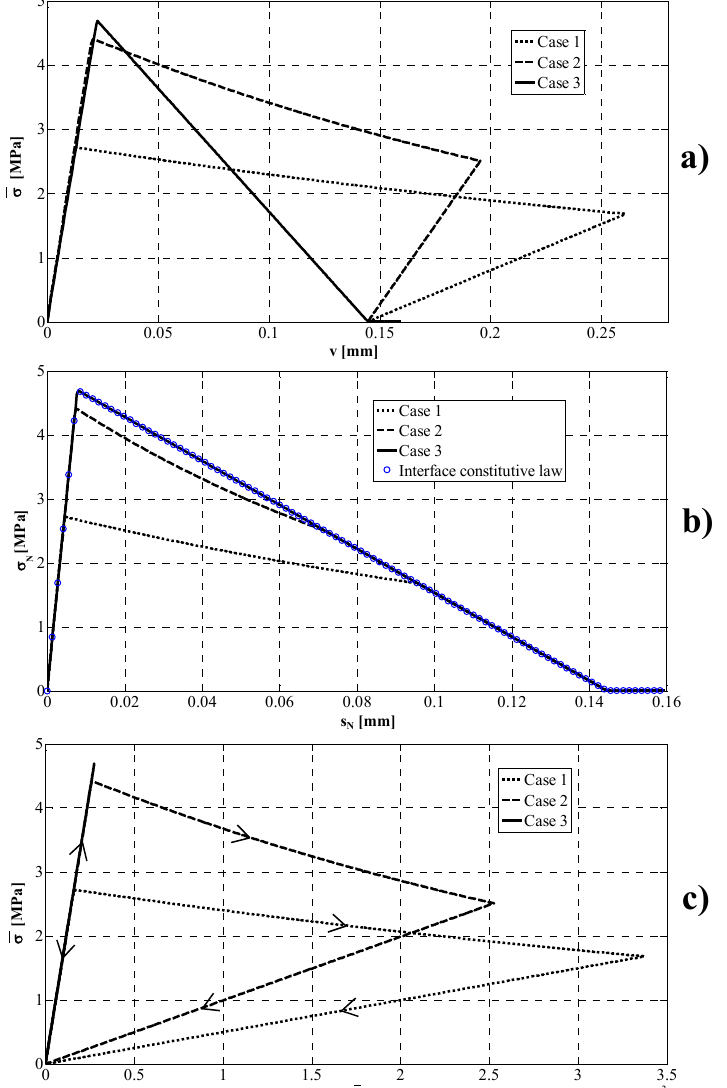
Figure 3: Numerical results obtained adopting the Model 1. a) Mechanical response of whole structure; b) Mechanical behavior of interface; c) Body tensile